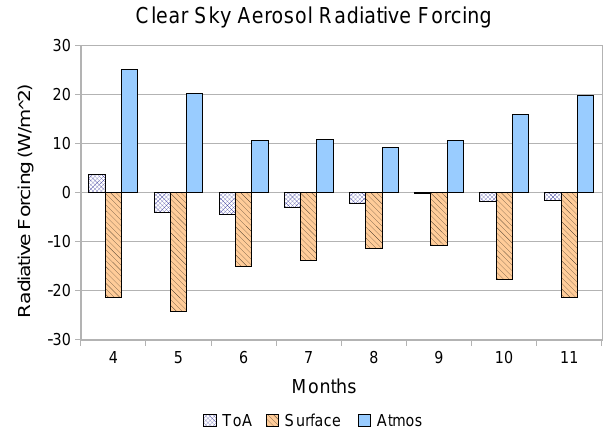
Fig. 11. Clear sky aerosol radiative forcing over Gadanki computed using monthly mean AOD